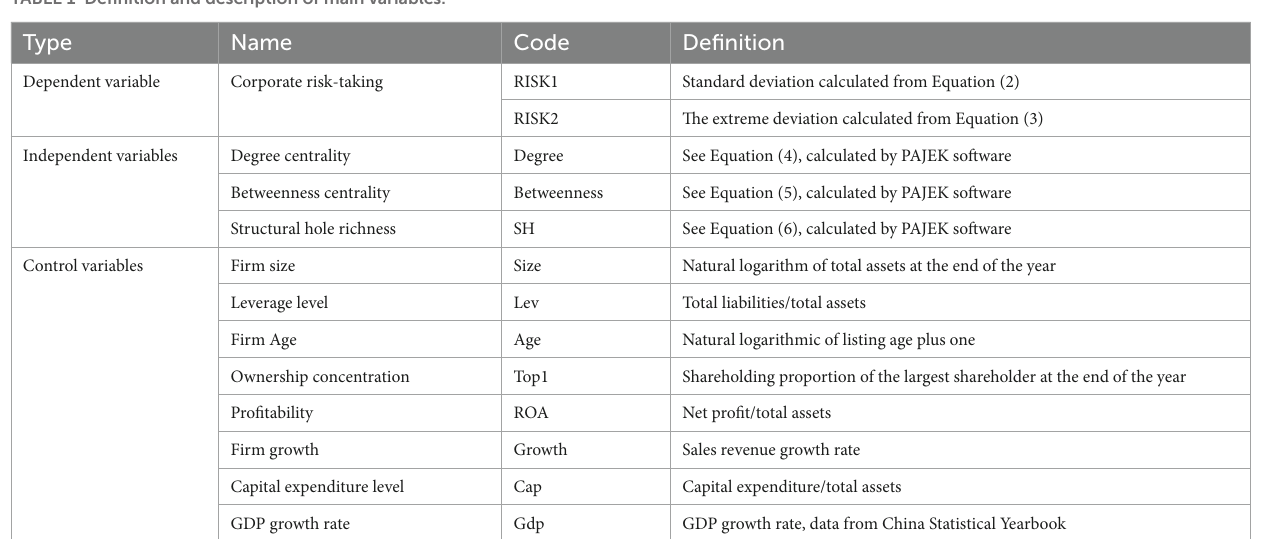
TABLE 1 Definition and description of main